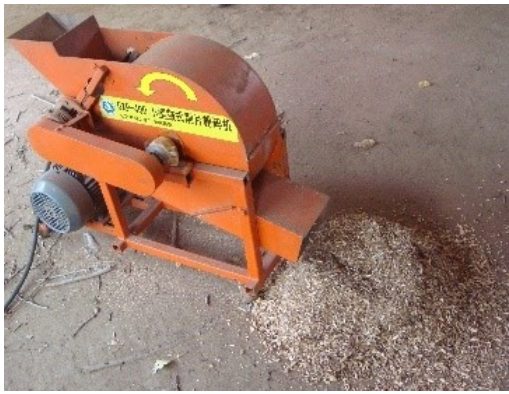
Figure 1. The GXP-400 crumbling equipment.